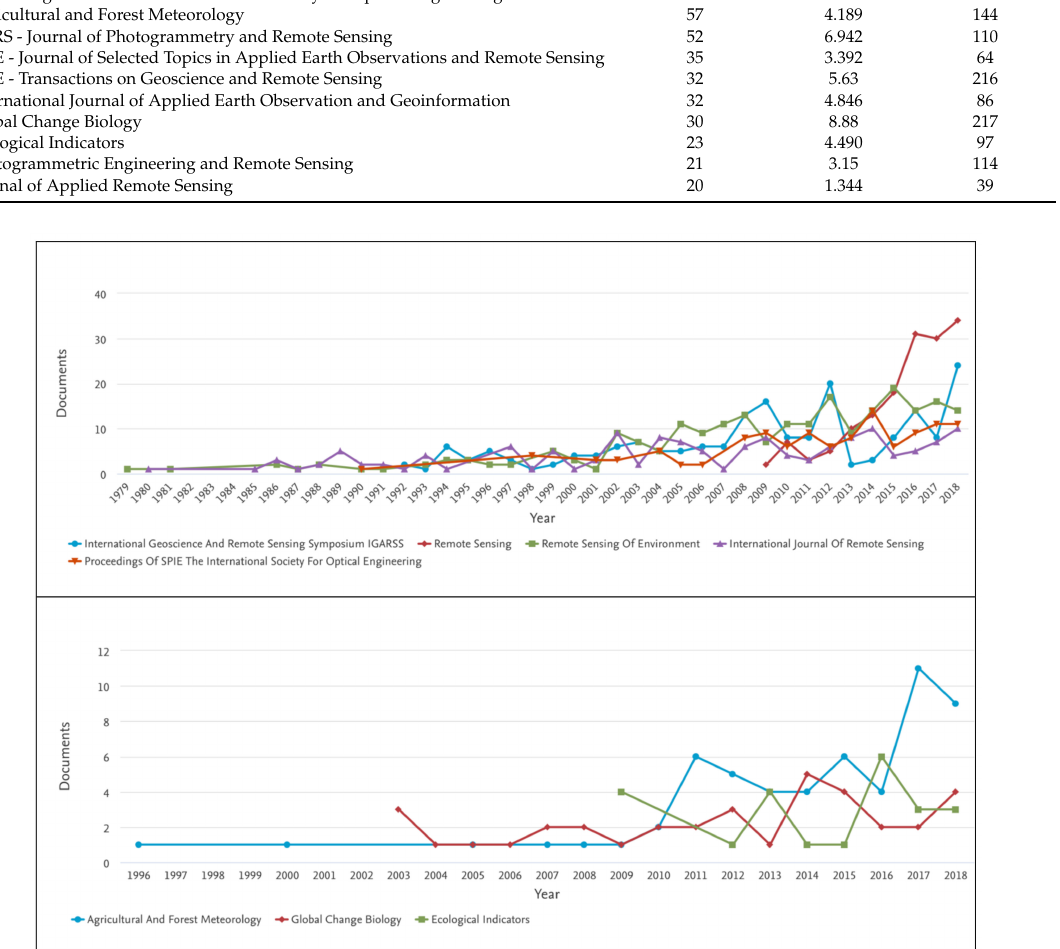
Figure 2. Temporal trend of publications in rs + pheno studies over the period 1979–2018 for the five most publishing remote sensing-based journals (upper panel) and the three most publishing ecology-based journals (lower